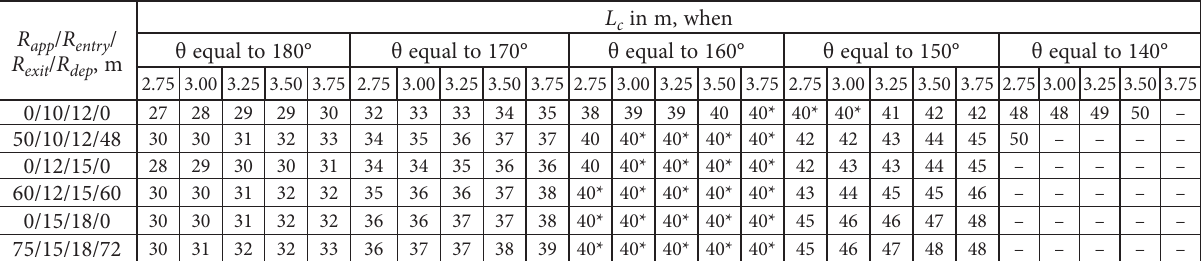
Table 5. Minimum ICD values, which satisfy the β recommendation (β up to 45°), according to different geometric parameters of the roundabouts